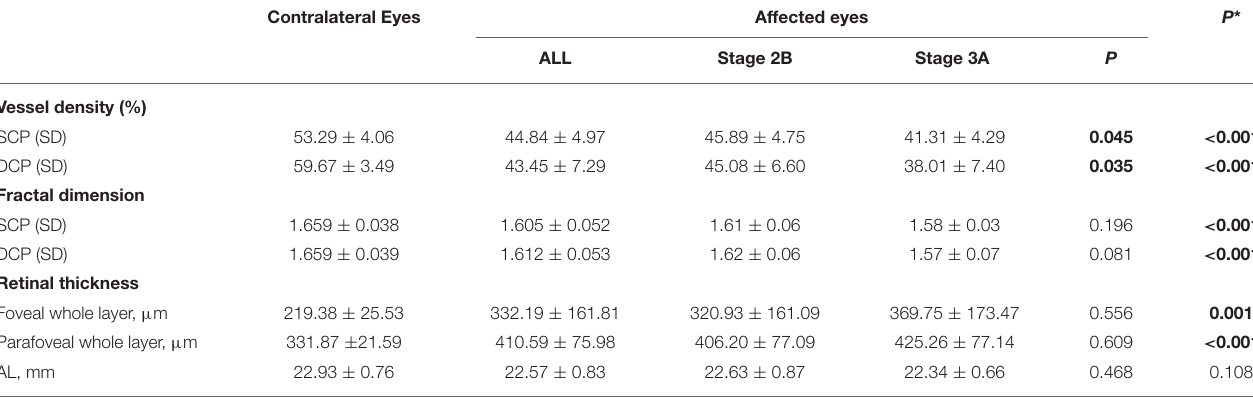
TABLE 3 | OCTA parameters of eyes with macular edema or exudation secondary to Coats’ disease.